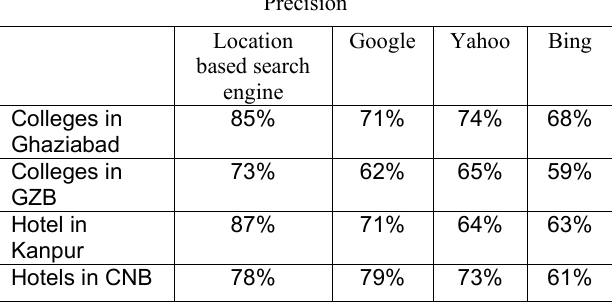
Table 8. Comparison of Geo/Non-Geo